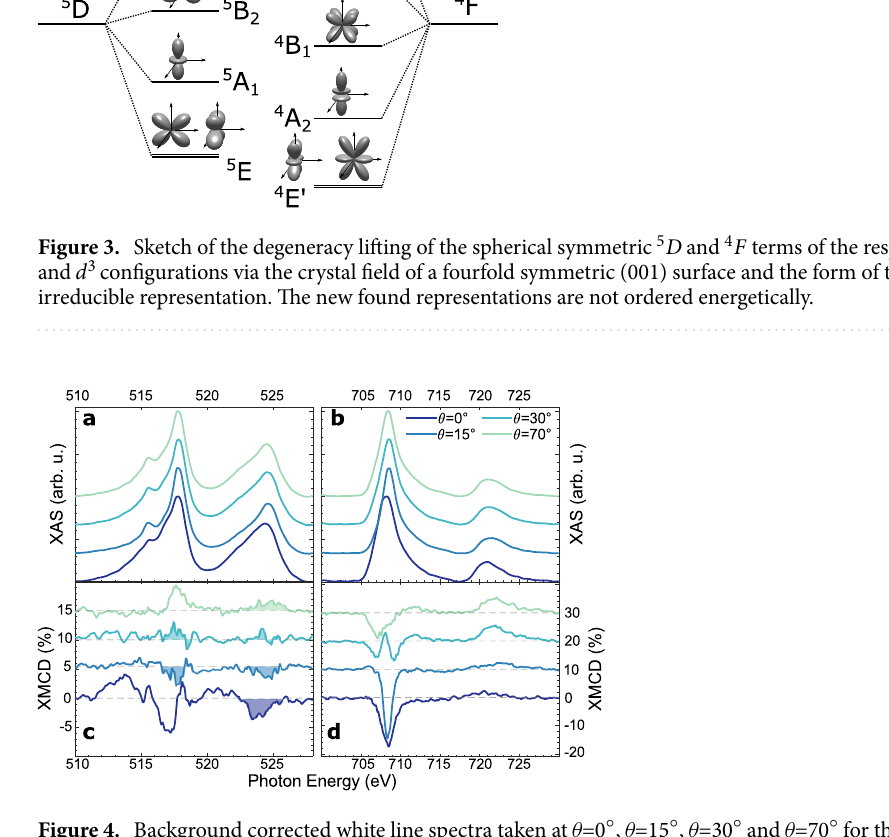
Figure 4. Background corrected white line spectra taken at θ =0 ( a ) and the Fe L 2,3 -edges ( b ) of Fe 1 V 1 /Cu(001). ( c ) and ( d ) are the XMCD spectra corresponding to ( a ) and ( b ). All spectra are normalized to the L 3 peak value of the corresponding white line spectrum and vertically offset for better